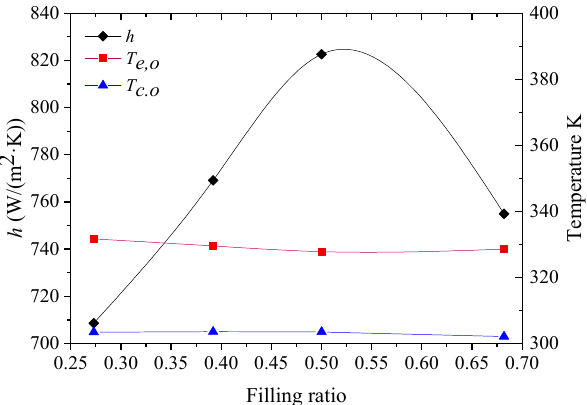
Figure 5. Heat transfer performance under different filling ratio.